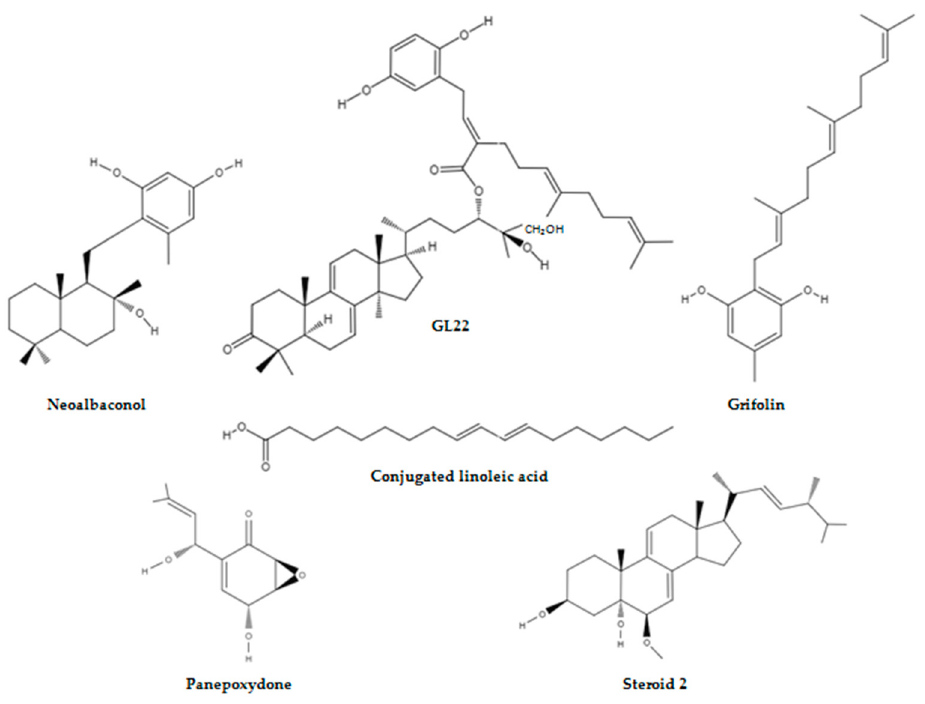
Figure 3. Structures of mushroom-derived compounds that target energy-relevant regulators in can- cer.